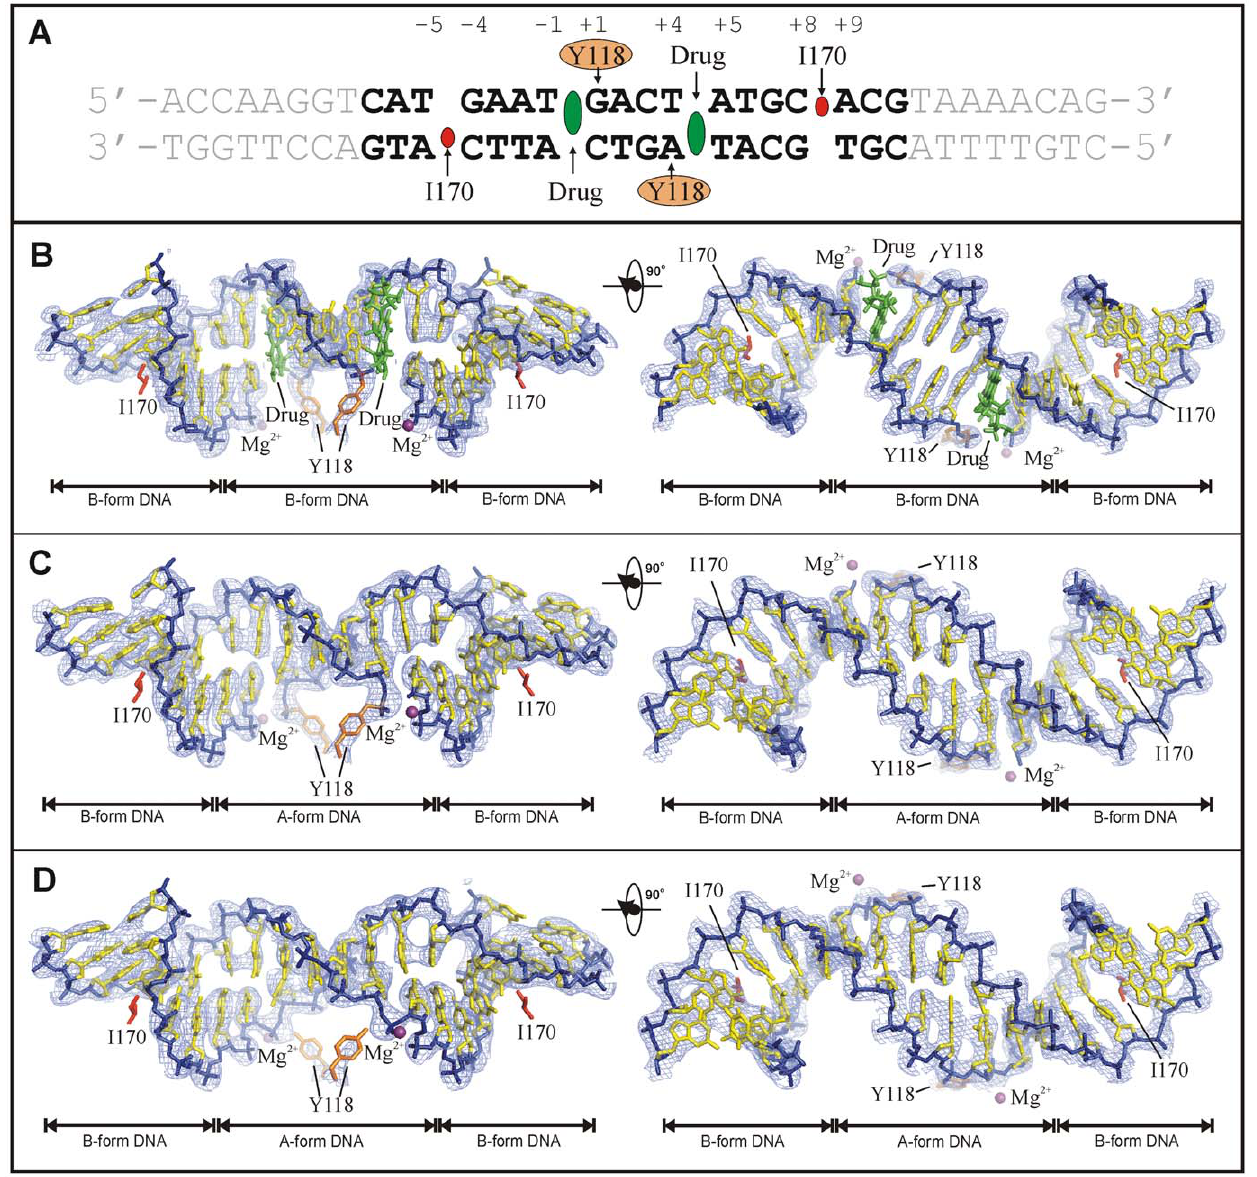
Figure 4. Molecular and conformational changes at the DNA gate. A , E-site DNA sequence with important positions involved in protein-DNA and PD 0305970-DNA interactions indicated. The highlighted 18-bp region is well resolved in the crystal structures. B–D , Drug-stabilised, drug-free cleaved and drug-free re-sealed topo IV-DNA cleavage complexes respectively. The DNA is in blue/yellow for backbone/bases. Active site tyrosines are in orange, intercalating isoleucines are in red and magnesium ions are in purple. The s A-weighted 2F obs -F calc map is contoured around the DNA/ Tyr 118 of the structure at 1.5 s (light-blue). In B the PD 0305970 molecules are in green. The remaining parts of the complex are omitted for clarity.